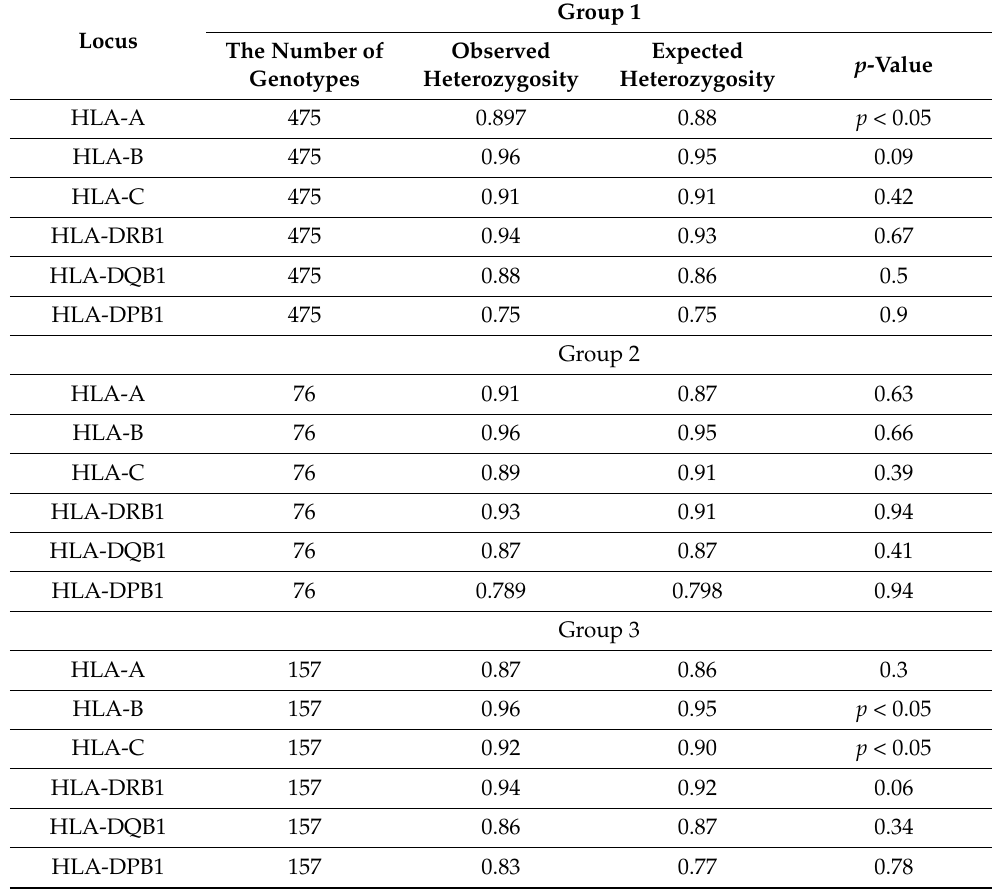
Table 4. Hardy-Weinberg equilibrium in studied